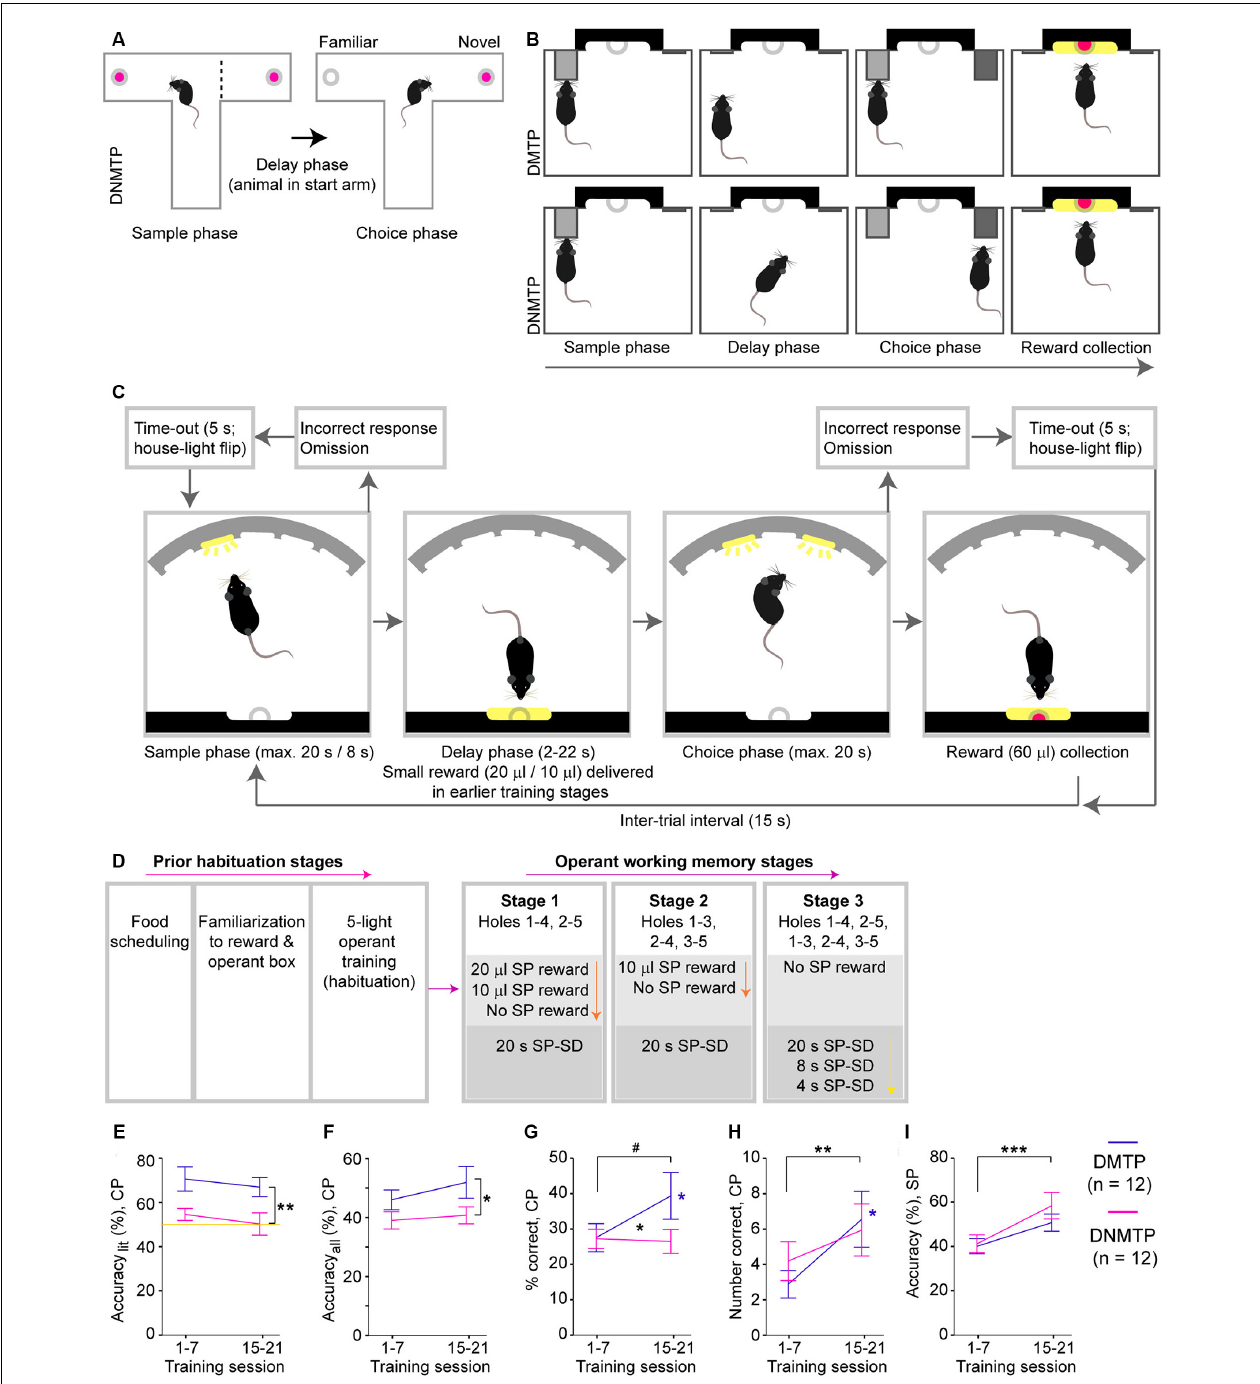
FIGURE 1 | Sequence, training schedule and acquisition of a 5-choice-based operant working memory (WM) task in mice. (A) Scheme of the T-maze rewarded alternation spatial WM (SWM) task, which follows a delayed-non-matching-to-position (DNMTP, win-shift) paradigm, whereby the goal arm visited in the sample phase (SP, left) has to be avoided in the choice phase (CP, right) to obtain a reward (pink). However, mice also intrinsically prefer the correct goal arm as it is more novel than the incorrect goal arm. (B) Simple lever-based operant testing of SWM can follow either a delayed-matching-to-position (DMTP, top) or a DNMTP (bottom) paradigm, whereby a previously presented lever (gray, SP) has to either be pressed again (DMTP) or avoided in favor of another lever (DNMTP, dark gray) in the CP to obtain a reward. In both paradigms, mice can encode the future correct choice by placing their body in front of the correct lever during the delay phase. (C) 5-choice based operant testing of SWM (5-CSWM) reduces this confound of the lever-based task and offers more options to manipulate task difficulty: mice need to poke